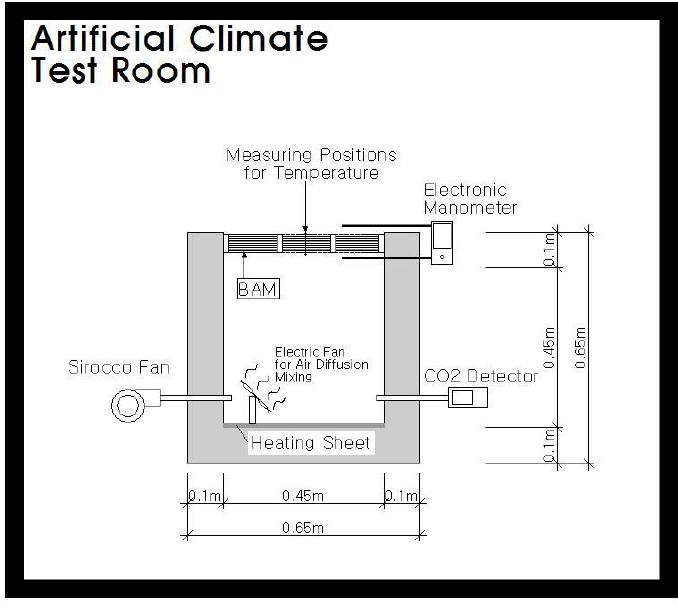
Figure 4. Experimental setup for simulating the effects of wind variation [5].